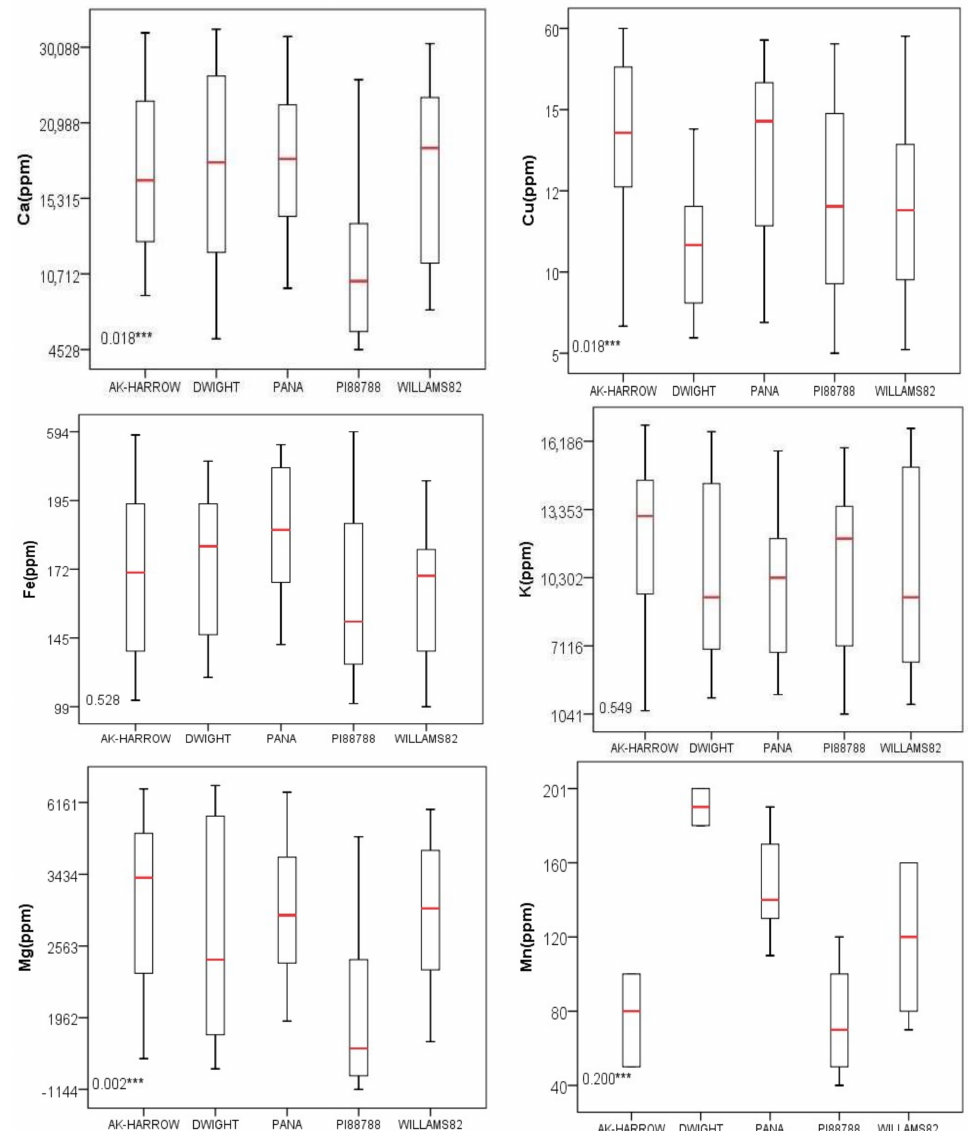
Figure 3. Variation in mineral nutrient concentration among soybean species on 17 July 2014. Whiskers indicate the 5th and 95th percentiles. Solid lines inside the box represent the median; the colored areas represent the 25th and 75th percentiles. The significant level is also shown (*** p < 0.05). The results indicate that K and Fe are less significant among soybean cultivars at the early growth stage. When plants were not yet exposed to significant ozone damage, on 17 July 2014, foliar concentrations of Ca, Fe, Mn were lower and K concentration was higher for ozone-sensitive cultivars AK-HARROW and PI88788 than the rest of the